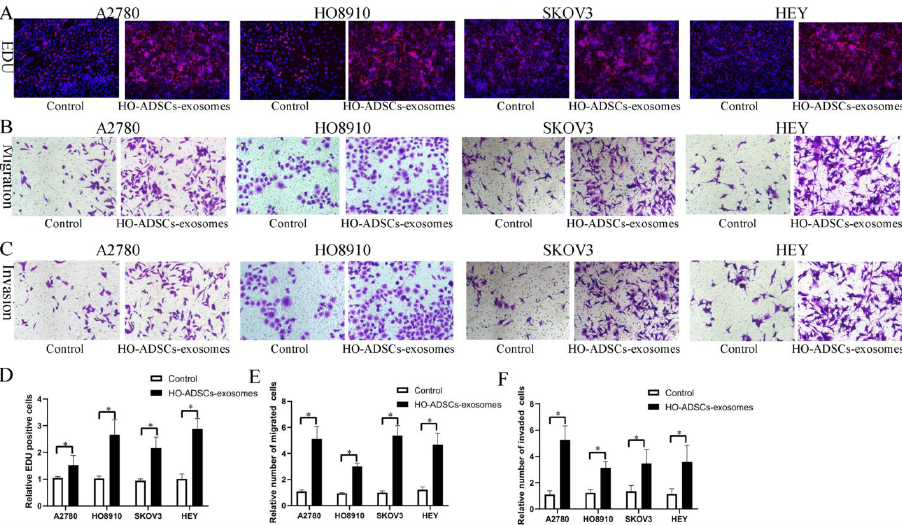
Figure 3. HO-ADSC exosomes promote human EOC cell proliferation, migration, and invasion (A2780, HO8910, SKOV3, and HEY) in vitro. ( A ). The influence of HO-ADSC exosomes on human EOC cell proliferation was measured by EdU assay. ( B ). The influence of HO-ADSC exosomes on human EOC cell migration was measured by Transwell assay. ( C ). The influence of HO-ADSC exosomes on human EOC cell invasion was measured by Transwell assay. ( D) . Quantification of proliferation rates showed that the proliferative capacity of human EOC cell lines was significantly improved when exposed to HO-ADSC exosomes. ( E ). Quantification of the migrating cells showed that the migratory capacity of human EOC cell lines was significantly improved when exposed to HO-ADSC exosomes. ( F ). Quantification of the invasion rates of human EOC cell lines showed that the invasive capacity of human EOC cell lines was significantly improved when exposed to HO-ADSC exosomes. * p < 0.05, n =